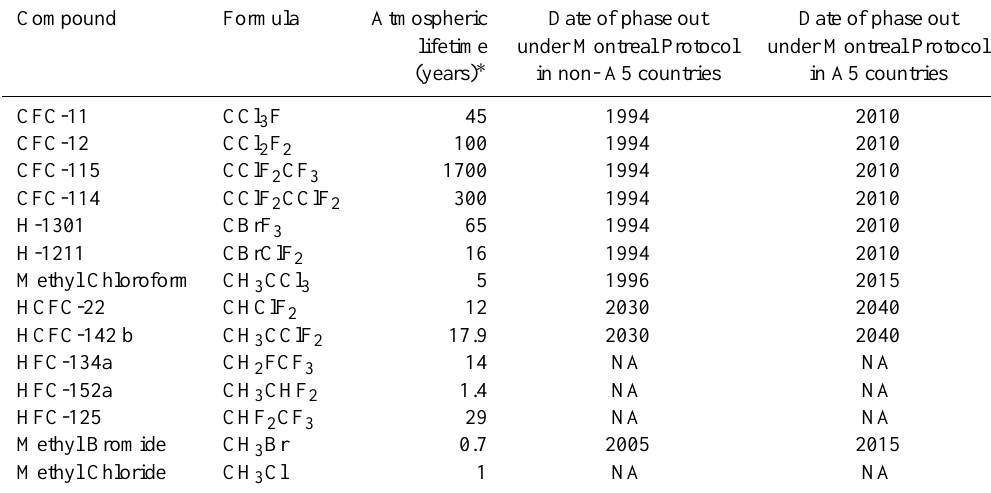
Table 2. List of the halocarbons considered in this study, lifetimes and phase out schedule under Montreal Protocol and subsequent amend-